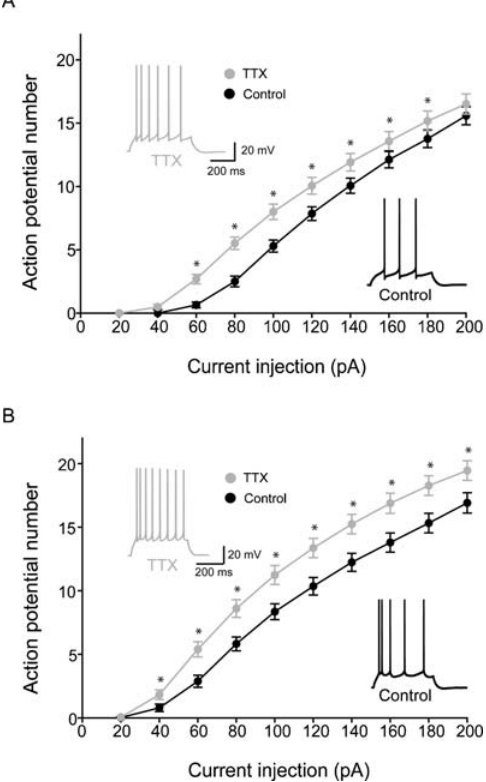
Figure 7. Increased intrinsic excitability in CA1 cells from adult and juvenile rats after in vivo TTX-application. (A,B) Summary plots of action potential numbers as a function of current injection (from 2 60 mV; duration: 500ms; for number of cells and animals, see main text) from adult (A) and juvenile (B) rats, with representative traces from single cells. Asterisks indicate significant (p , 0.05) difference between the control and TTX groups.